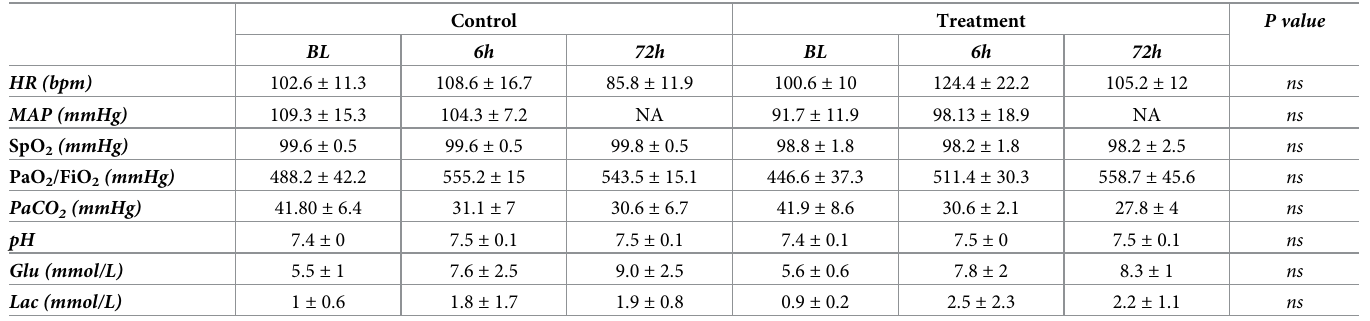
Table 2. Hemodynamic parameters and arterial blood gas analysis at baseline, 3, 6, and 72